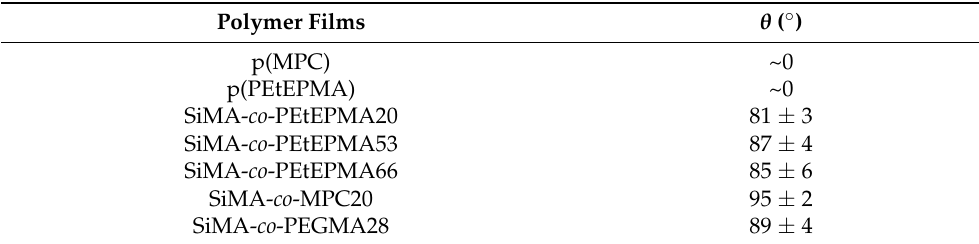
Table 3. Water contact angles of pristine (co)polymer films a